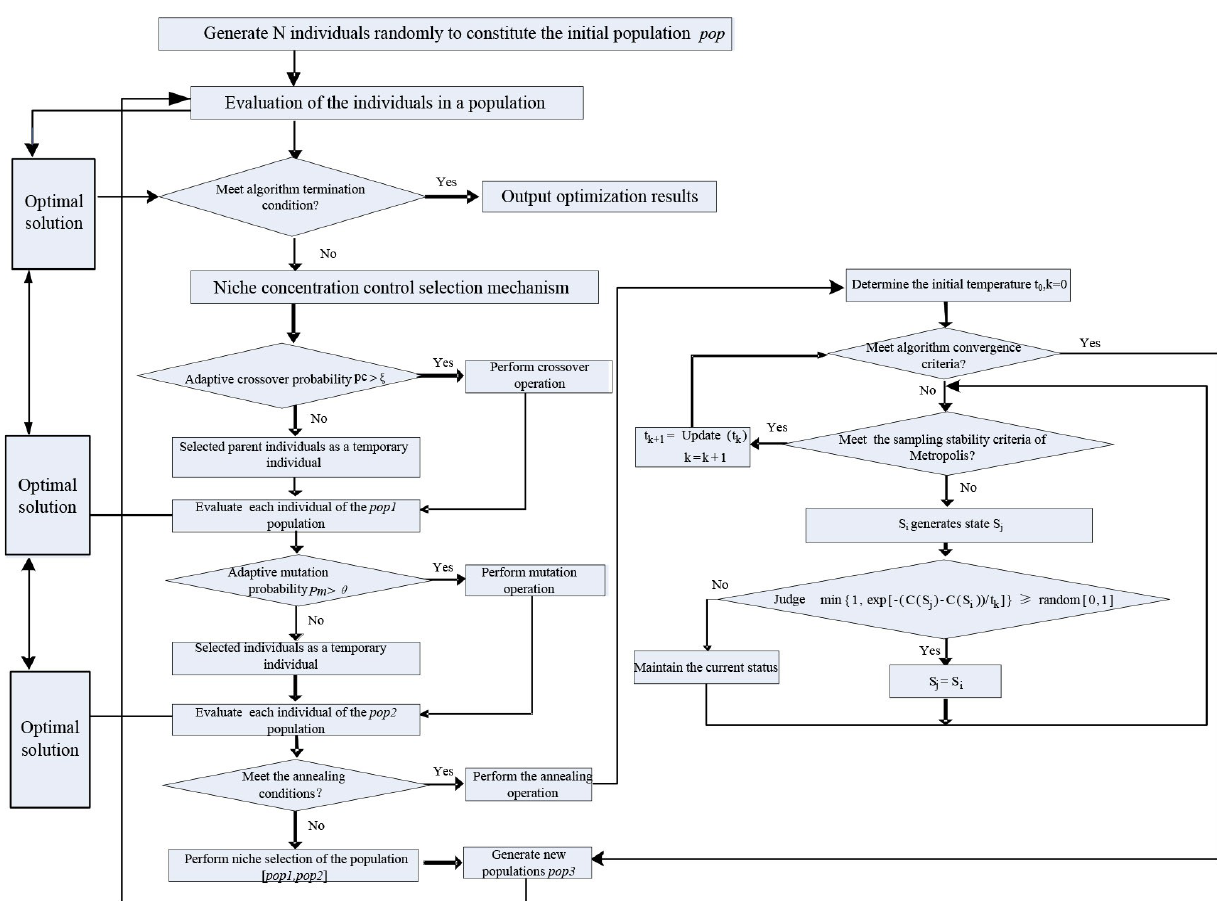
Figure 1. Flow chart of improved genetic annealing